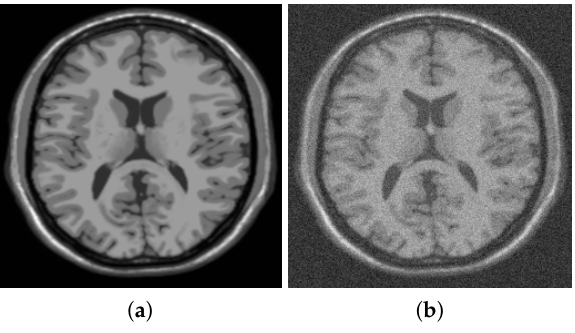
Figure 1. ( a ) Original (‘clean’) MRI image, ( b ) noisy MRI image (noise: 15 dB, Gaussian).